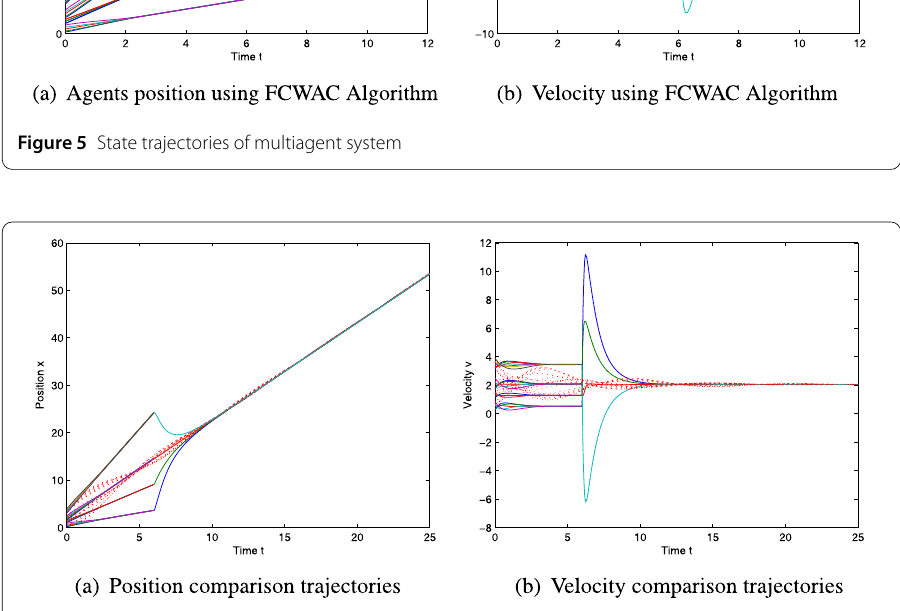
Figure 6 State trajectories of multiagent